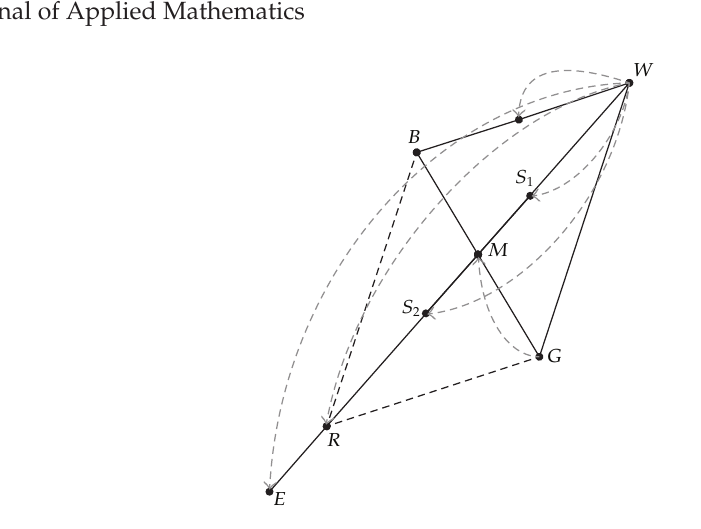
Figure 1: Illustration of the NM simplex